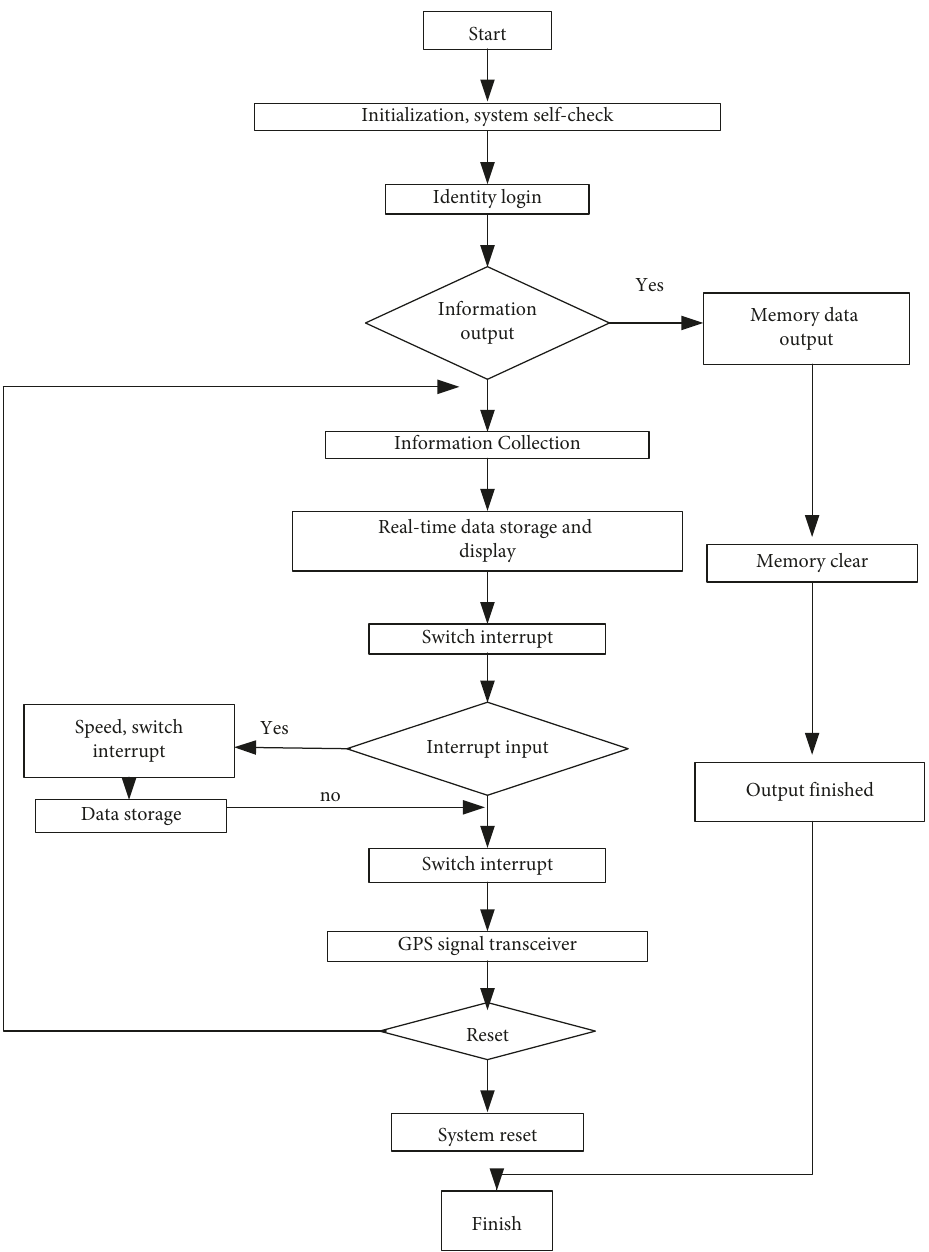
Figure 6: System program flow